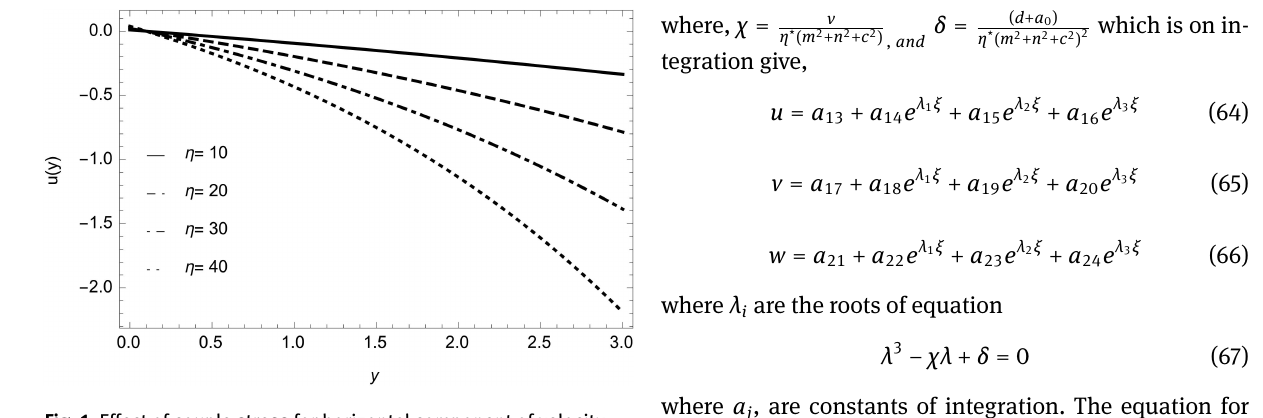
Fig. 1. Effect of couple stress for horizontal component of velocity versus y ( m = 1, u 0 = v 0 = 2) .